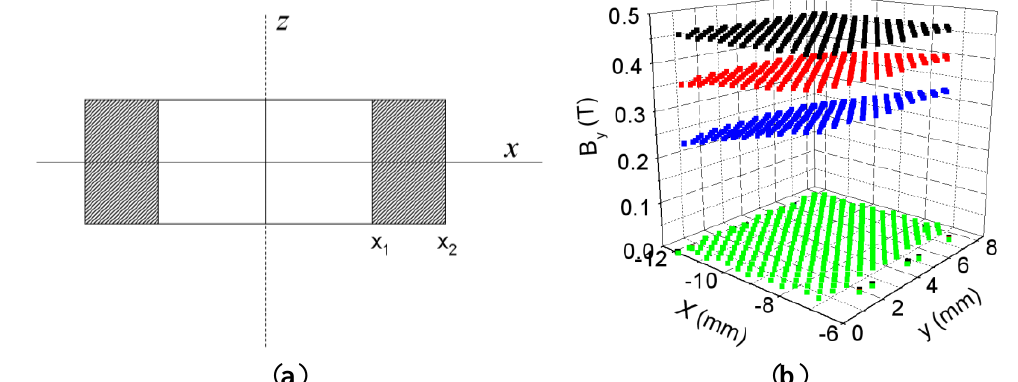
Figure 7. ( a ) Cross-section of the core in the xz plane; ( b ) Spatial distribution of B xz section of the core for I = 0.0057 A (    ), 0.16 A (    ) and 3 A (    ) obtained by